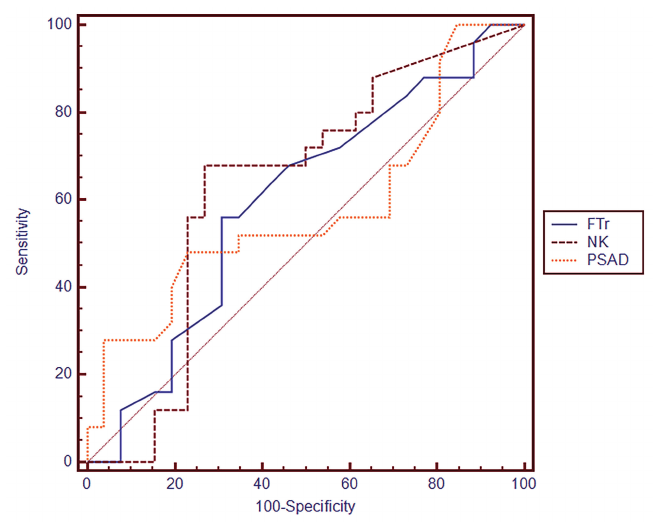
Figure 1 - Diagnostic criteria of the receiver operating characteristic (ROC) curve for the tested